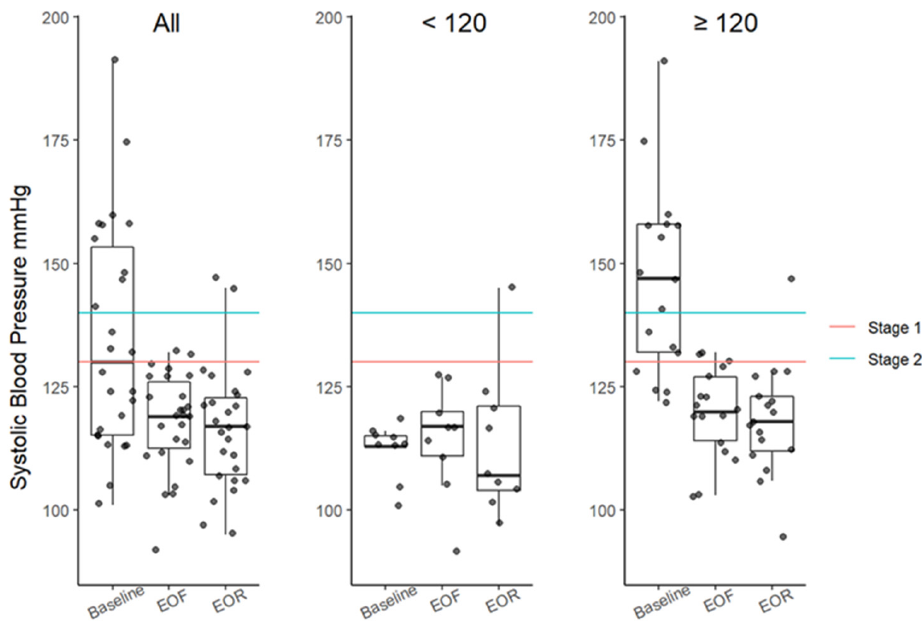
Figure 3. SBP boxplots at baseline, EOF, and EOR. Data categorized based on the risk threshold ( ≥ 120 mmHg). SBP between 130 mmHg (red line) and 139 mmHg is considered stage 1 hypertension. SBP ≥ 140 mmHg (blue line) is considered stage 2 hypertension. Boxplots represent the minimum value, first (lower) and third (upper) quartiles, the median, and the maximum value. EOF, end of fast; EOR, end of refeed; SBP, systolic blood pressure; mmHg, millimeters of mercury.